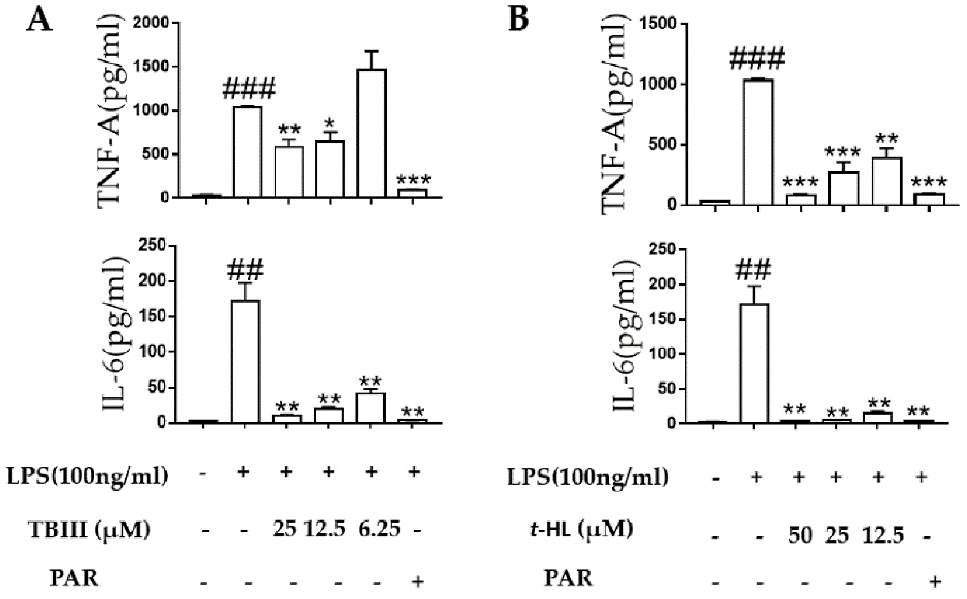
Figure 5. Effects of TBIII ( A ) and t -HL ( B ) on LPS-induced production of pro-inflammatory cytokines in N9 microglial cells. Cells were pre-treated with TBIII and t -HL for 1 h and then stimulated with LPS (100 ng/mL) for 24 h. The protein levels of TNF-α and IL-6 determined by ELISA according to manufacturer′s instructions. PAR (10 μM ) was used as a positive control. The data were obtained from three independent experiments and expressed as the means ± S.E.M. * p < 0.05, ** p < 0.01, *** p < 0.001 versus the LPS-treated group; ## p < 0.01, ### p < 0.001 versus the control group.